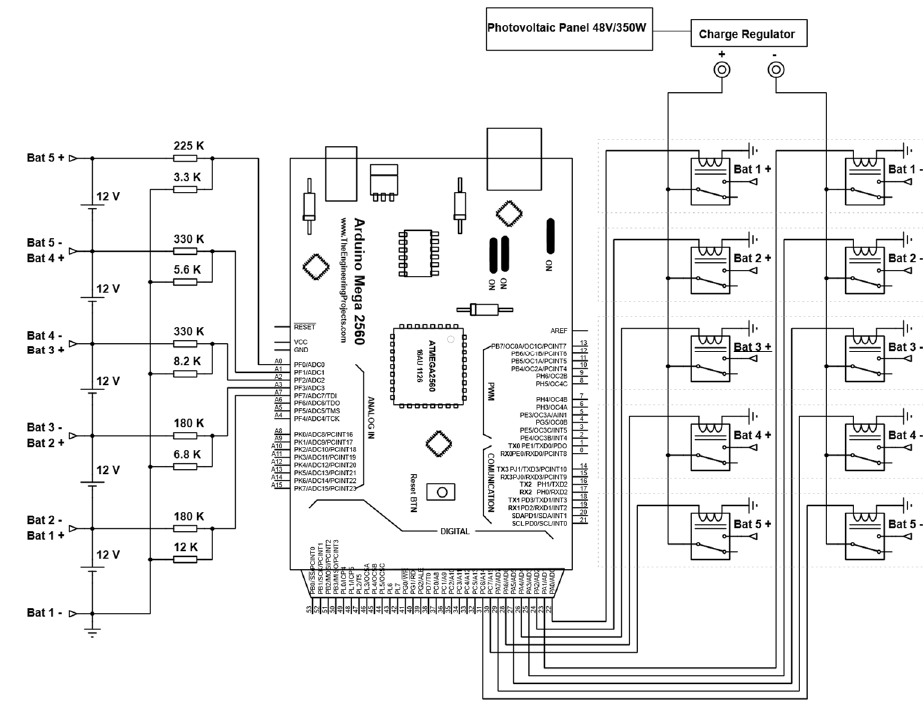
Figure 6. Schematic diagram of the load equalizer.